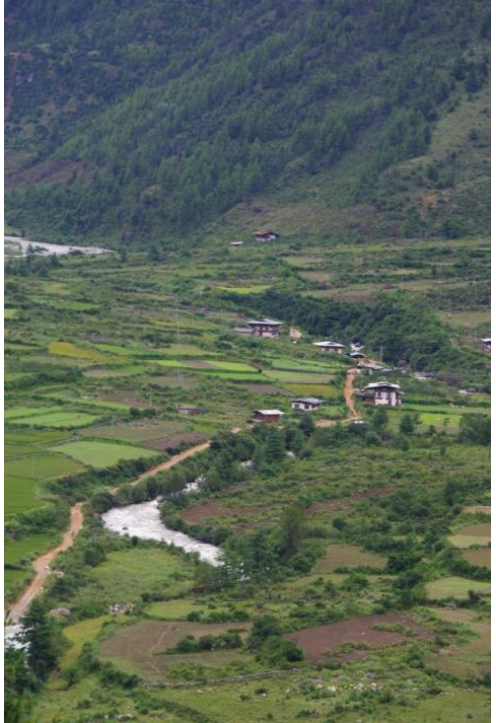
Figure 9. Jomolhari Trek from Drukgyel Dzong.